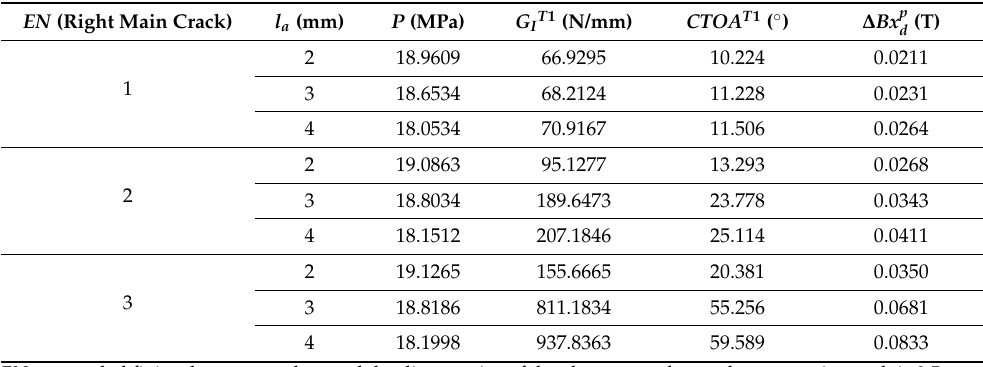
Figure 11. Crack propagation model under certain load steps. ( a ) P = 19.1265 MPa l a = 2 mm, ( b ) P = 18.8186 MPa l a = 3 mm, ( c ) P = 18.1998 MPa l a = 4 mm. Table 6. Influence of the auxiliary crack size.